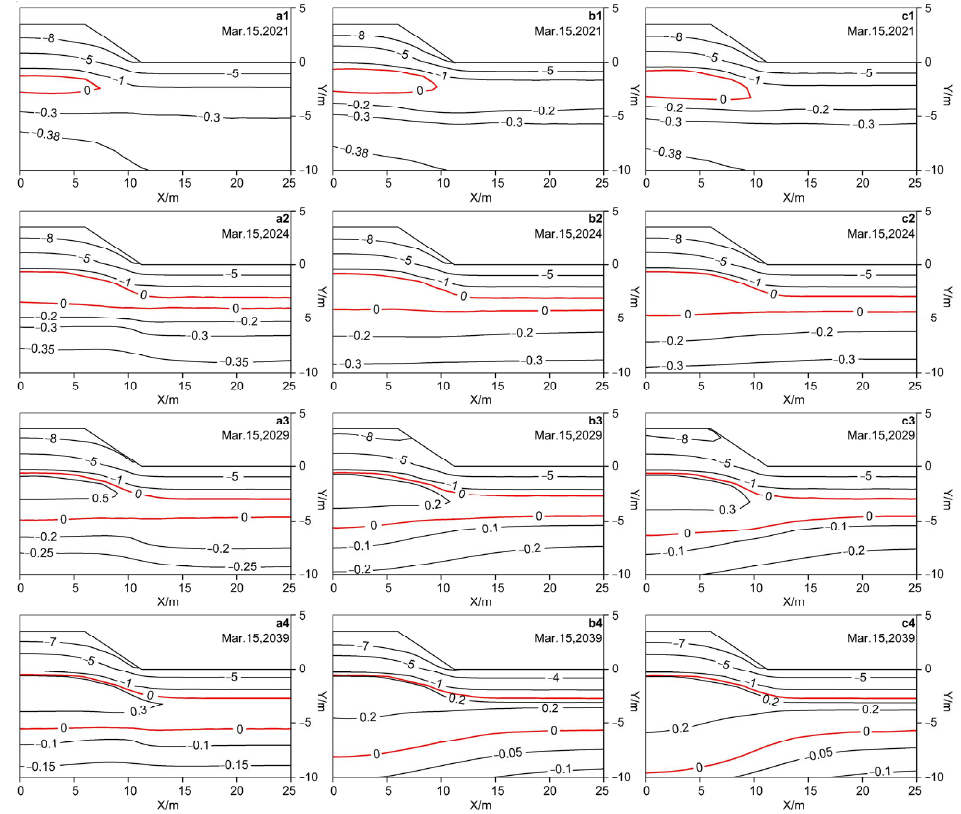
Figure 9. Temperature contour maps on March 15 of the three subgrade structures in different years: ( a1 – a4 ) replacement block–stone subgrade structure, ( b1 – b4 ) replacement breccia subgrade structure, and ( c1 – c4 ) replacement gravel subgrade structure. The 0 ℃ isotherm represents the thawed interlayer range. (Unit: ℃ ).